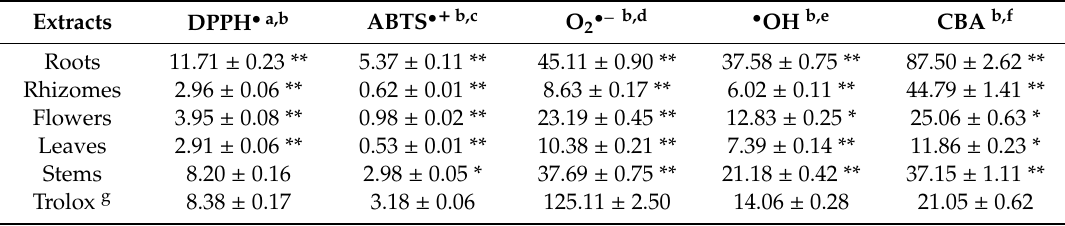
Table 4. Antioxidant activity of R. rosea